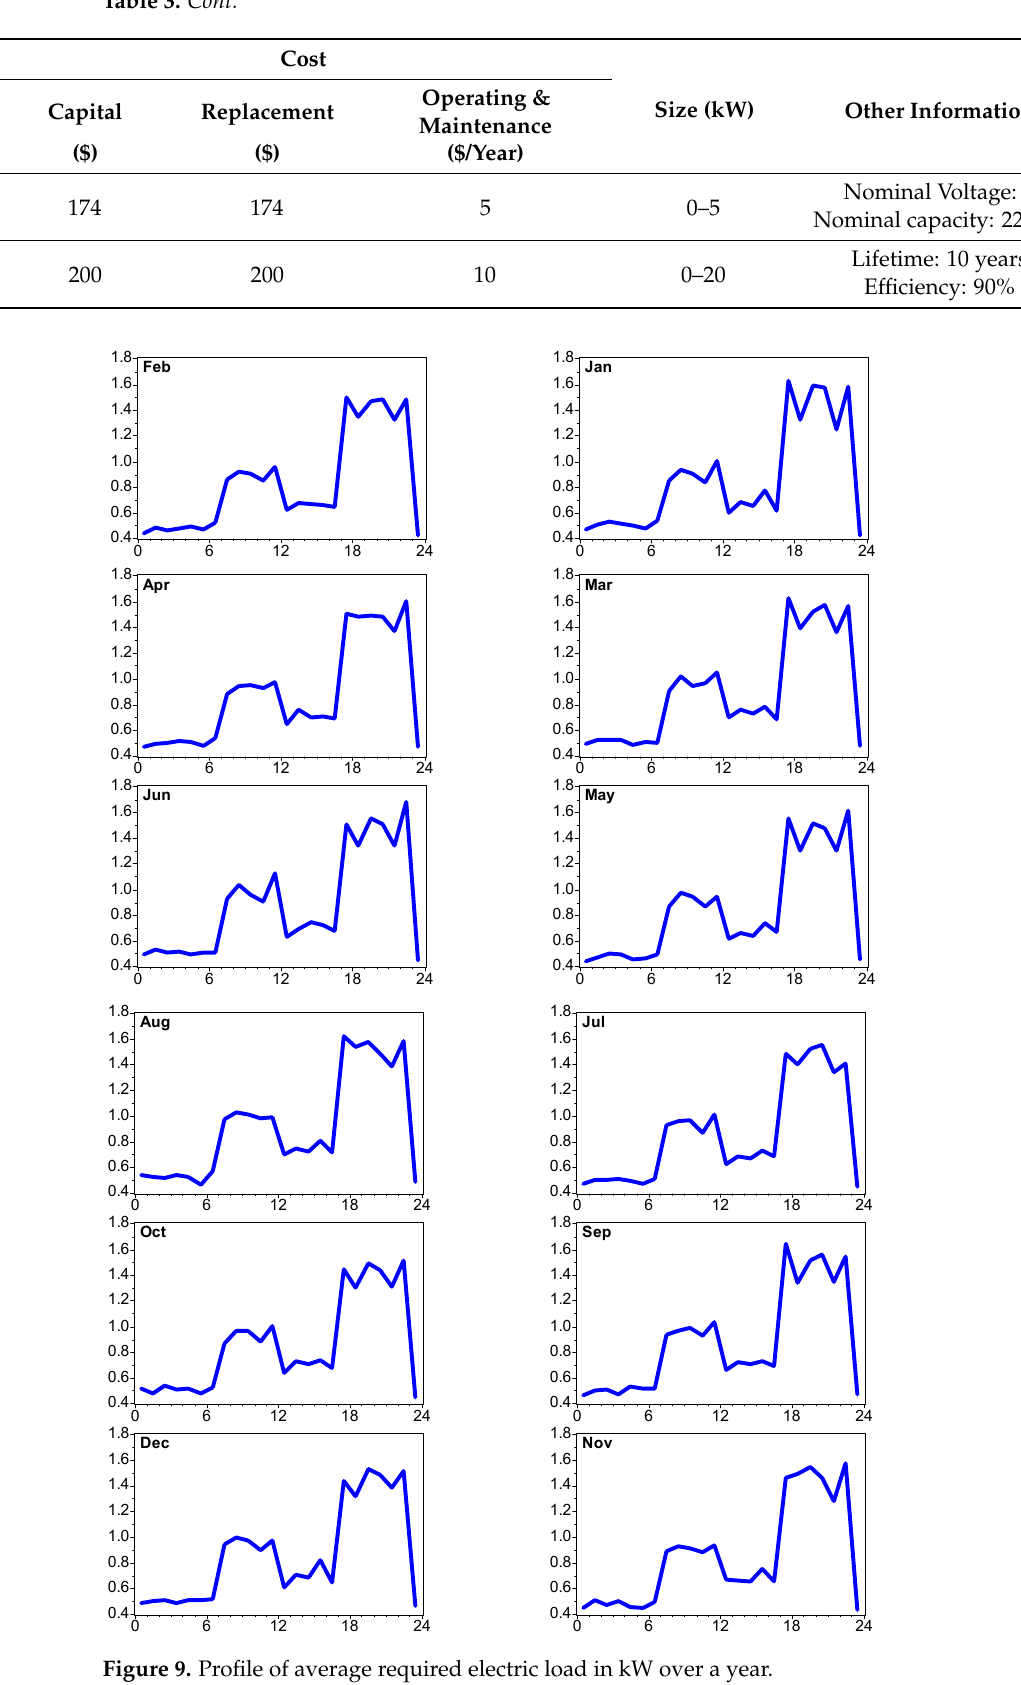
Figure 9. Profile of average required electric load in kW over a year . Table 3. Information of BIPV system under study.